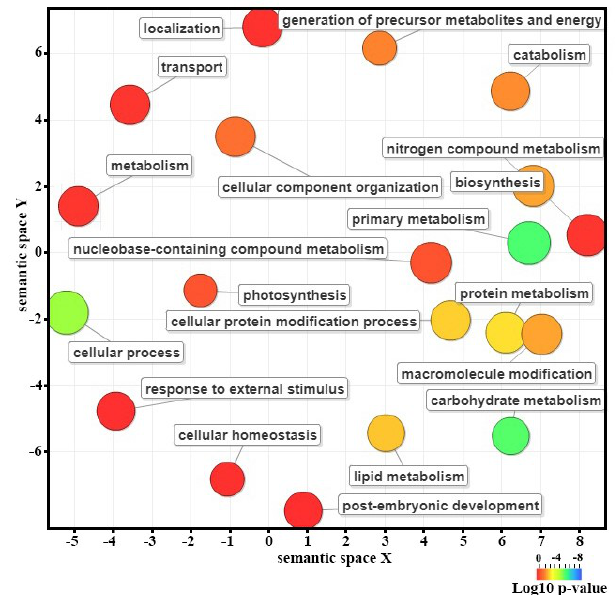
Figure 4. Gene ontology (GO) enrichment analysis of differentially expressed genes associated with CBCVd-infected hop plants. The GO terms cluster together in the semantic space according to functional similarity, without intrinsic meaning of semantic space units. Bubble color indicates indicate the p -value of enrichment according to the